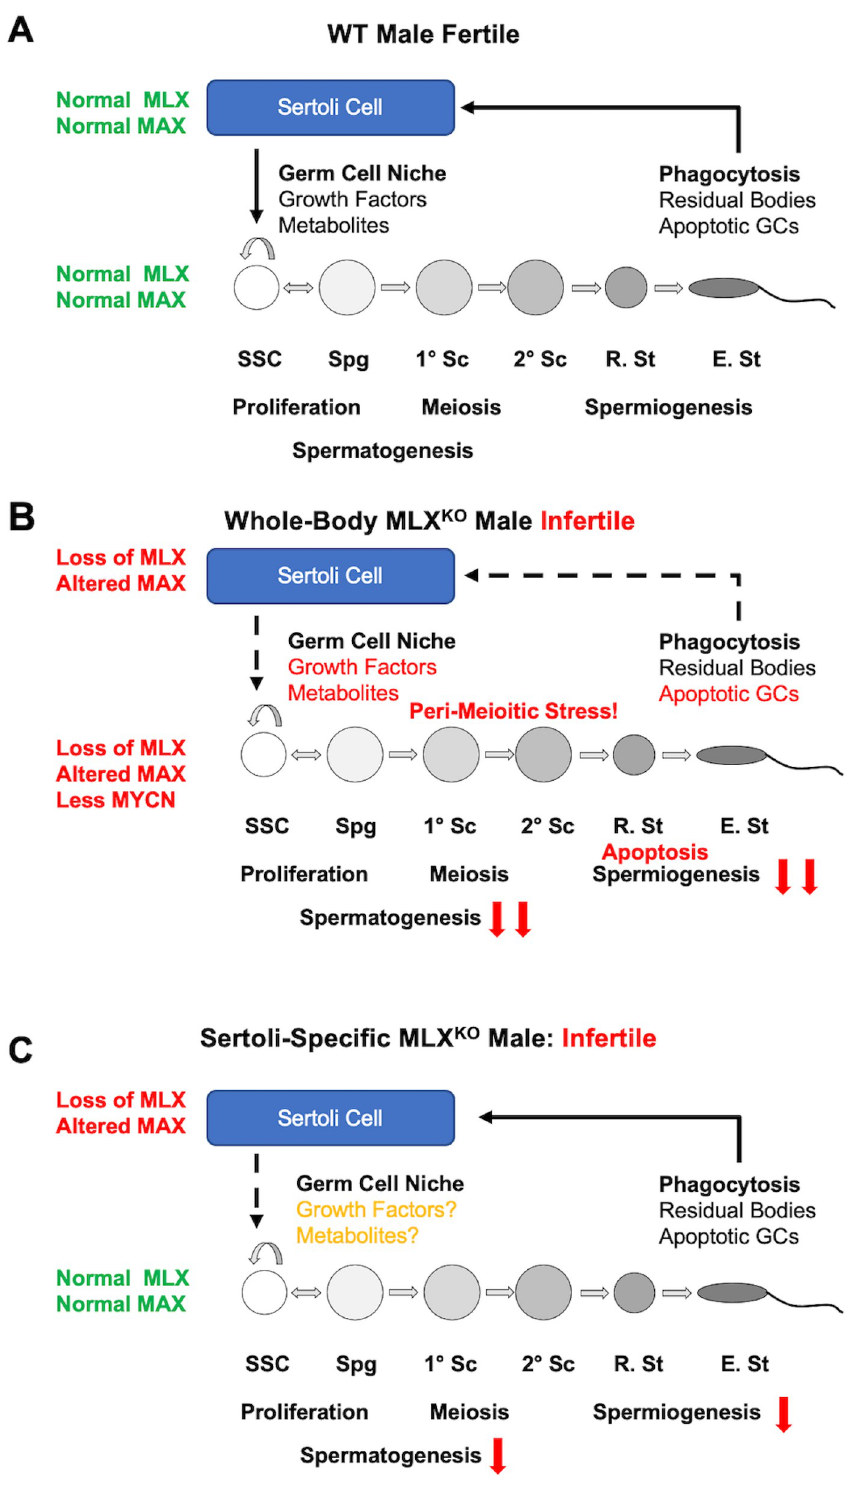
Fig 10. Models depicting the role of MLX in Sertoli and GC interactions during spermatogenesis. (A ) In normal WT male mice, MLX and MAX collaborate in both the Sertoli cell and spermatogenic cells to maintain the stem cell (SSC) pool as well as facilitate proper differentiation of Spg to Sc and subsequent R. St and E. St. Sertoli cells provide both the spermatogenic niche, as well as the recycling of critical components through phagocytosis of germ